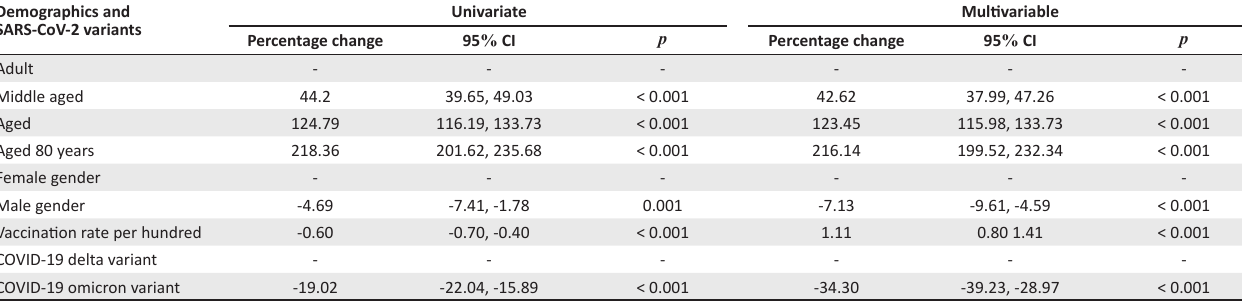
TABLE 3: Exponentiated log-linear model coefficient estimates for D-dimer values. Demographics and SARS-CoV-2 variants